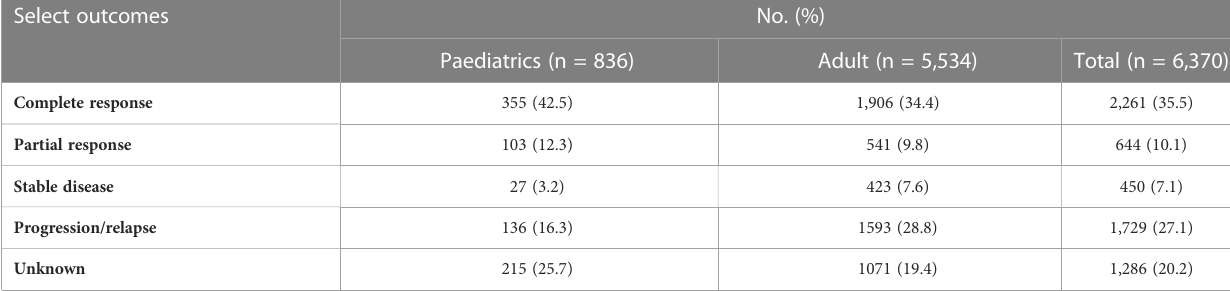
TABLE 4 Distribution of treatment responses among paediatric, adult, and total patients. Select outcomes